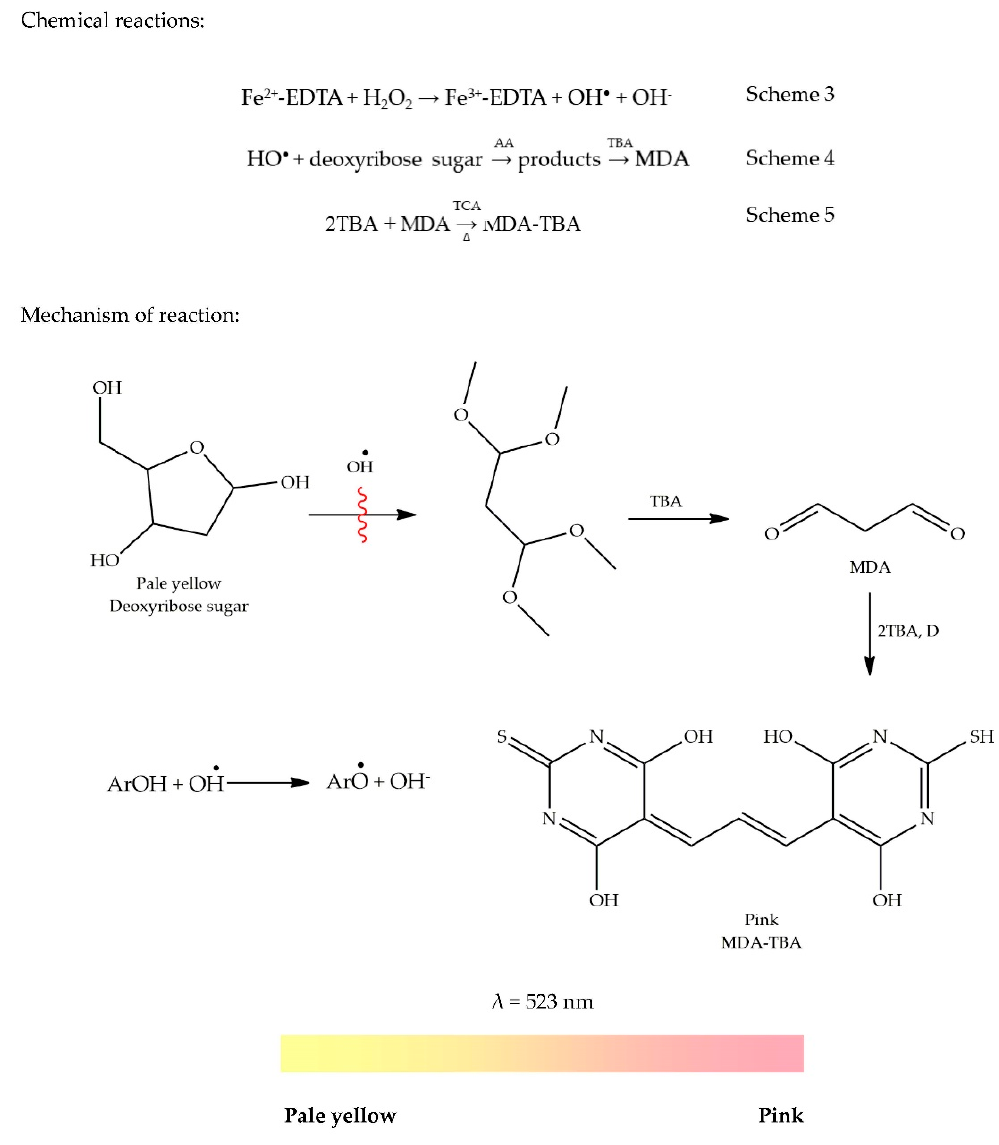
• reaction Figure 5. HO • reaction mechanism. Figure 5. HO